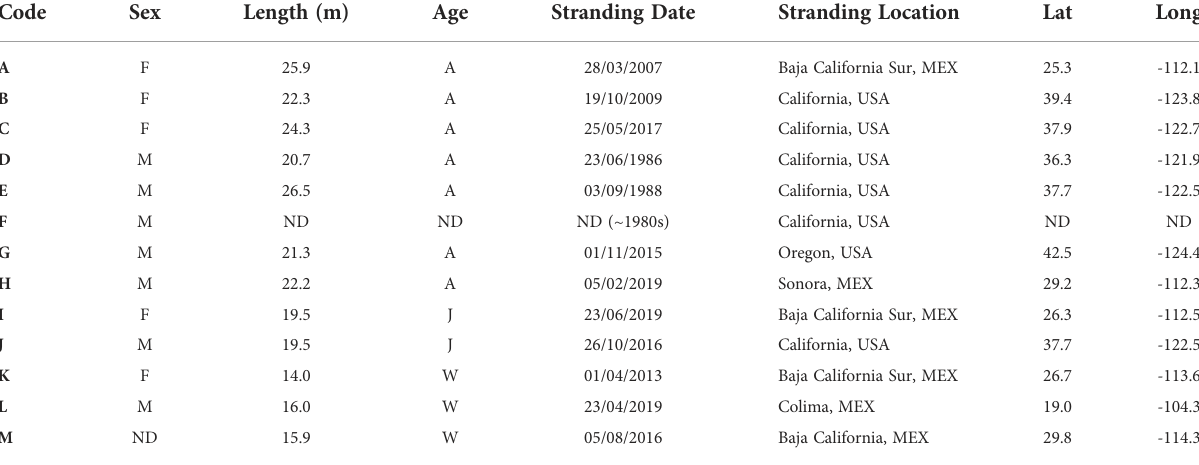
TABLE 1 Baleen plates collected from dead blue whales in the northeast Paci fi c